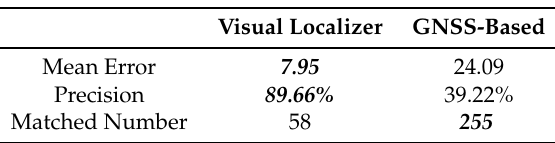
Table 4. The performance comparison between Visual Localizer and GNSS-based localization. The bold and italic items denote the